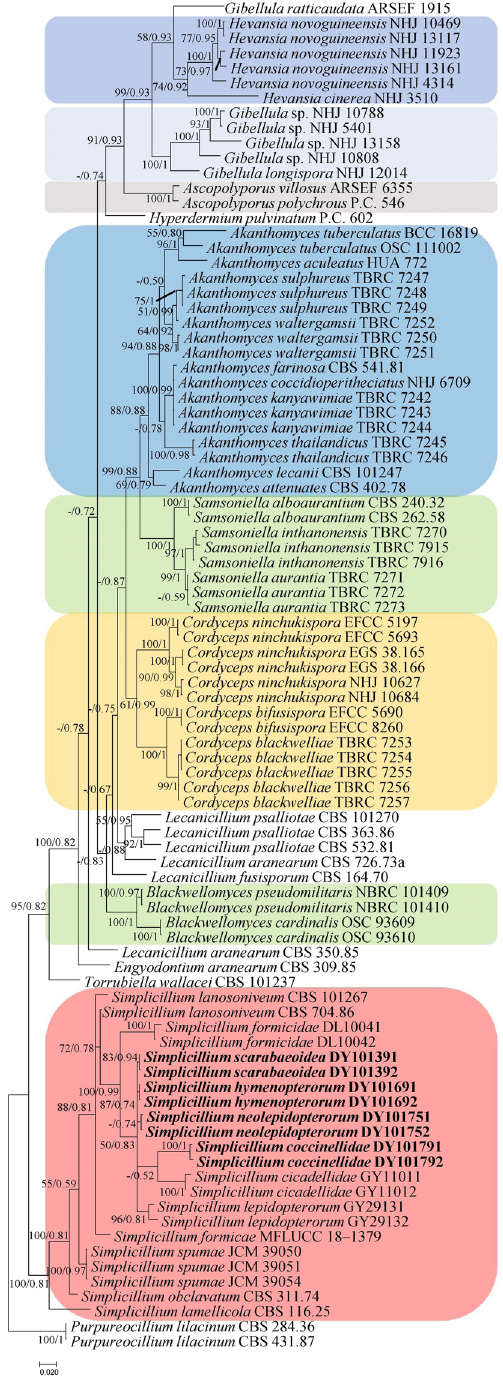
Figure 1. Phylogenetic relationships among the genus Simplicillium and closely-related species in Cordycipitaceae based on multigene dataset ( LSU , RPB1 and TEF ). Statistical support values (≥ 70%/0.7) are shown at the nodes for ML bootstrap support/BI posterior